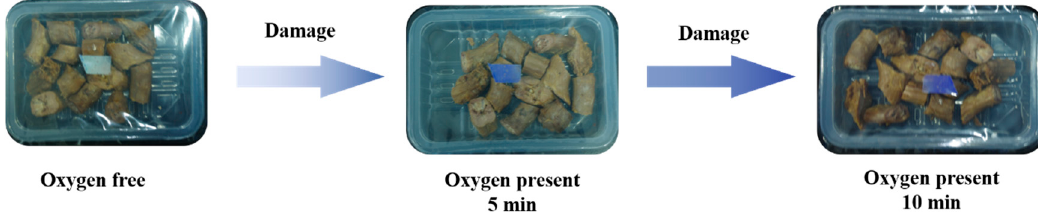
Figure 9. Color change of oxygen indicator in packaging of duck neck (10 min, room temperature).